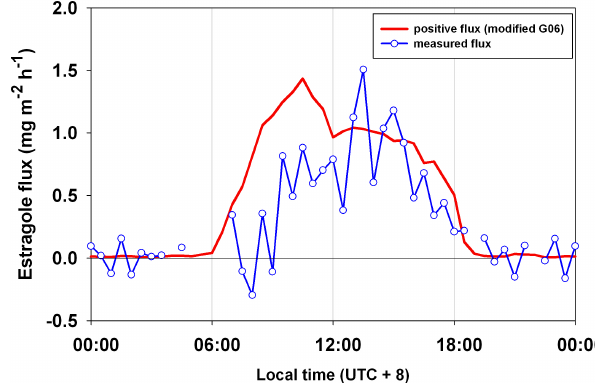
Fig. 9. Diurnal patterns for measured estragole flux (blue) in rela- tion to modelled emission by modified G06 (red).The current G06 algorithm is unable to accurately represent the second peak of es- tragole (occurring at 13:00–18:00h), which could be due to pos- sible thermogenesis and/or specific circadian control of emission. The whole dataset was used to constrain the algorithm, so that the morning peak is overestimated by the modelled